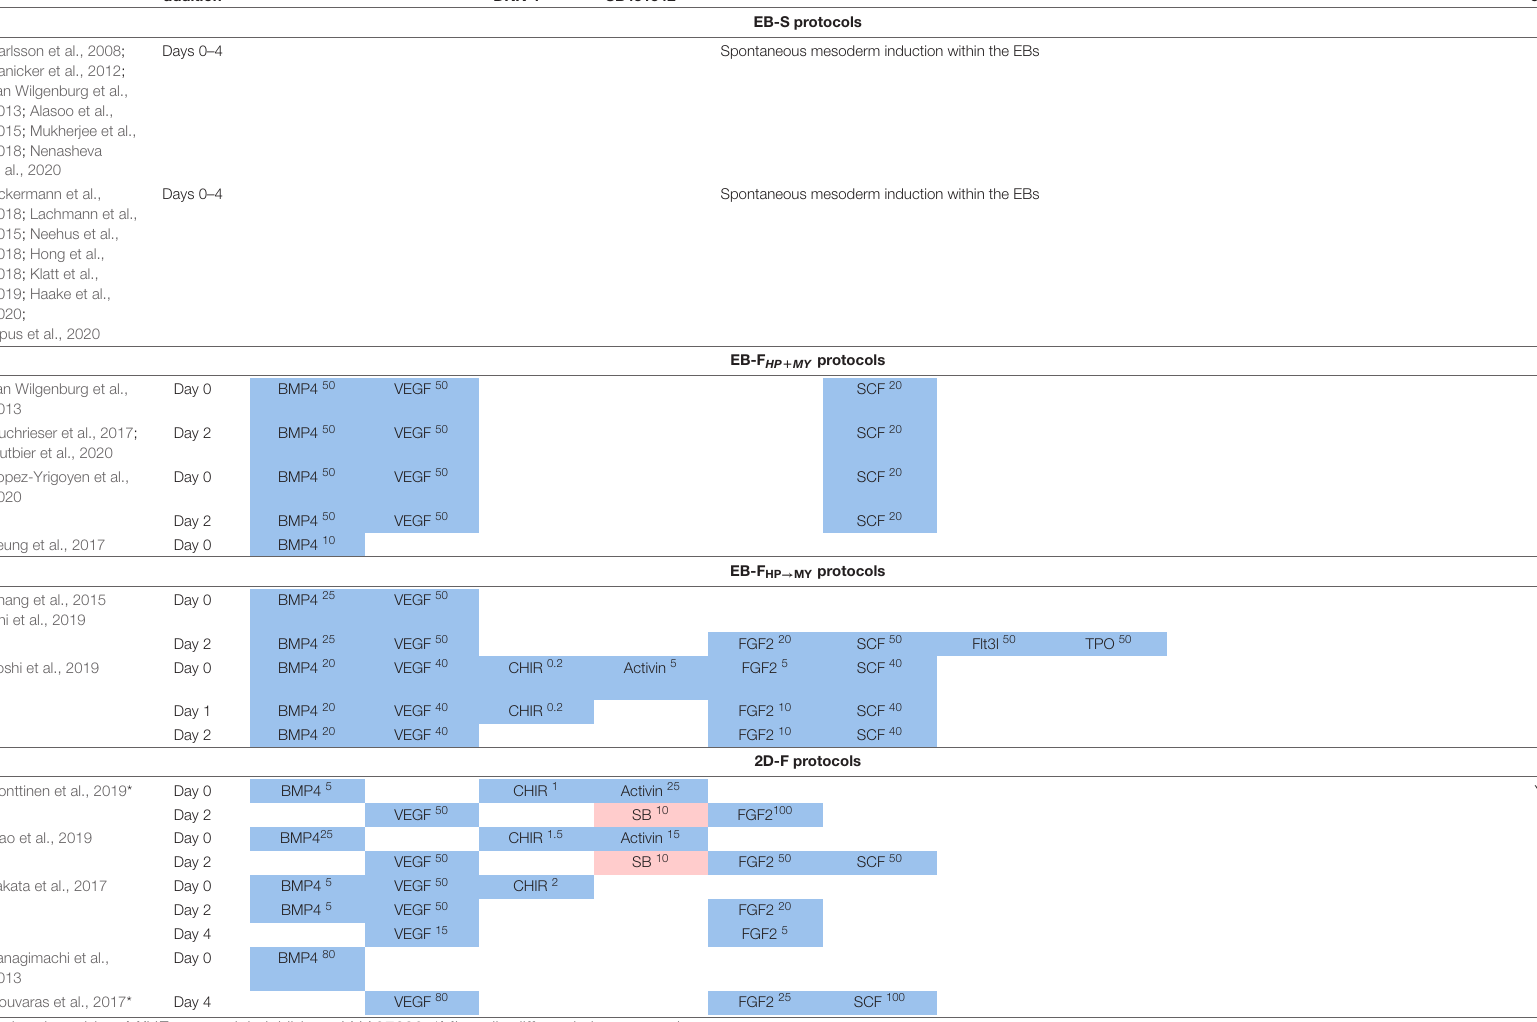
Color clues: blue, M/HE stage; pink, inhibitors. Y, Y-27632. *Microglia differentiation